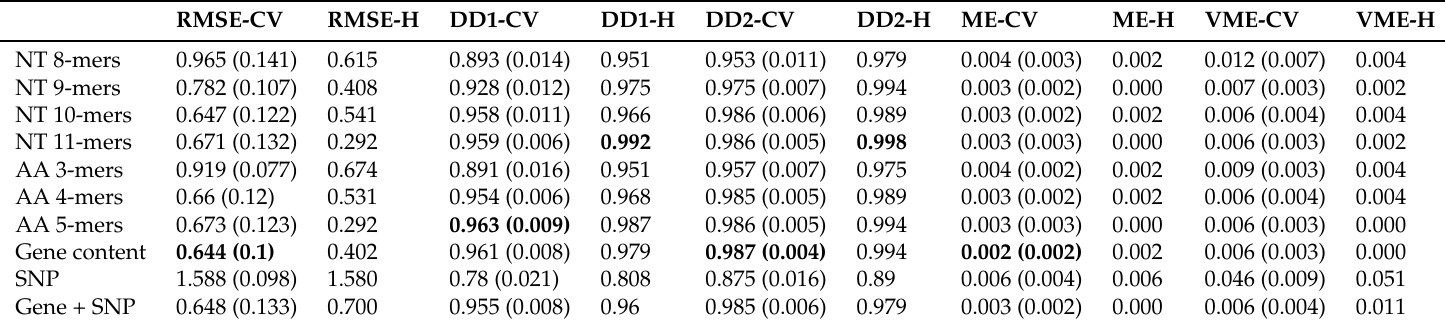
Table A55. S. enterica –ceftriaxone.